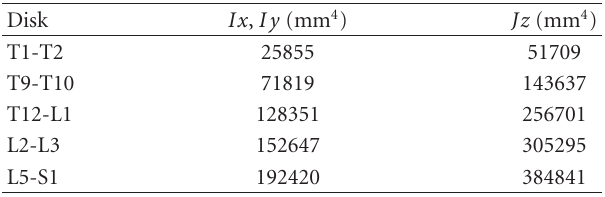
Table 2: The structural properties of disks.